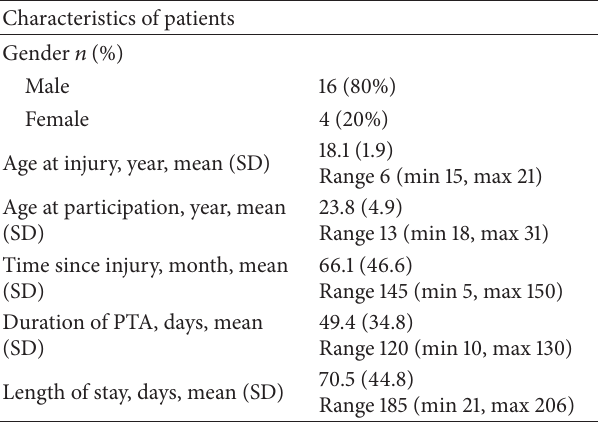
Table 1: Sample characteristics ( 𝑛 = 20